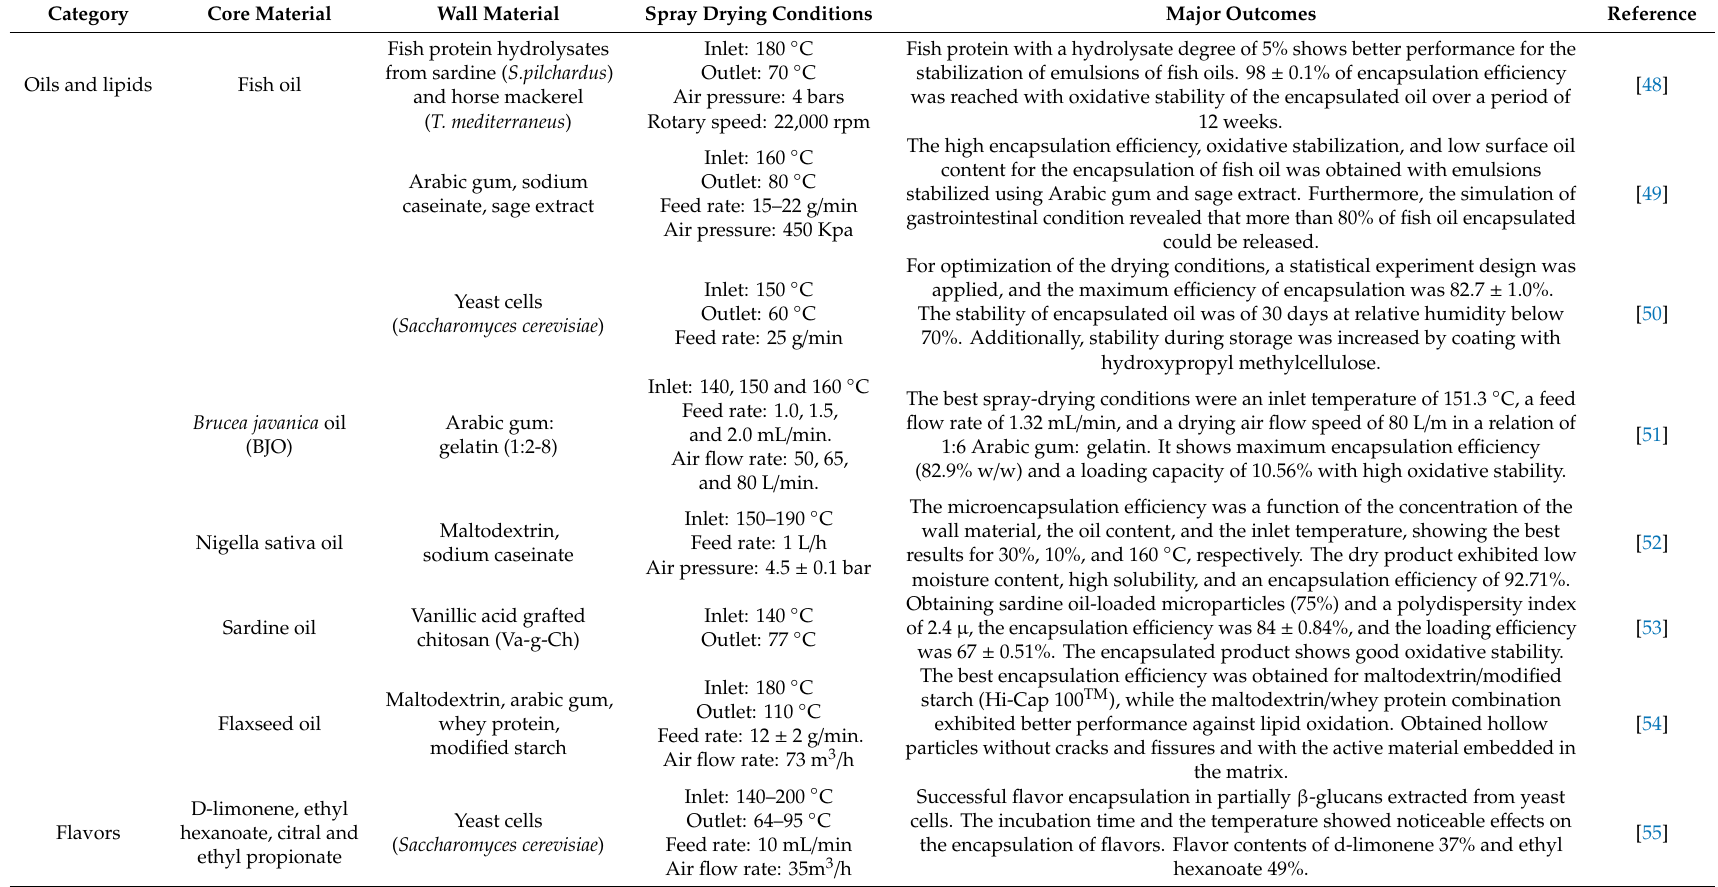
Table 1. Encapsulation of flavors, oils and lipids, bioactive ingredients, and food